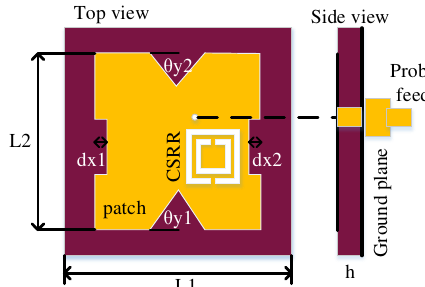
Figure 1: Geometry of the proposed